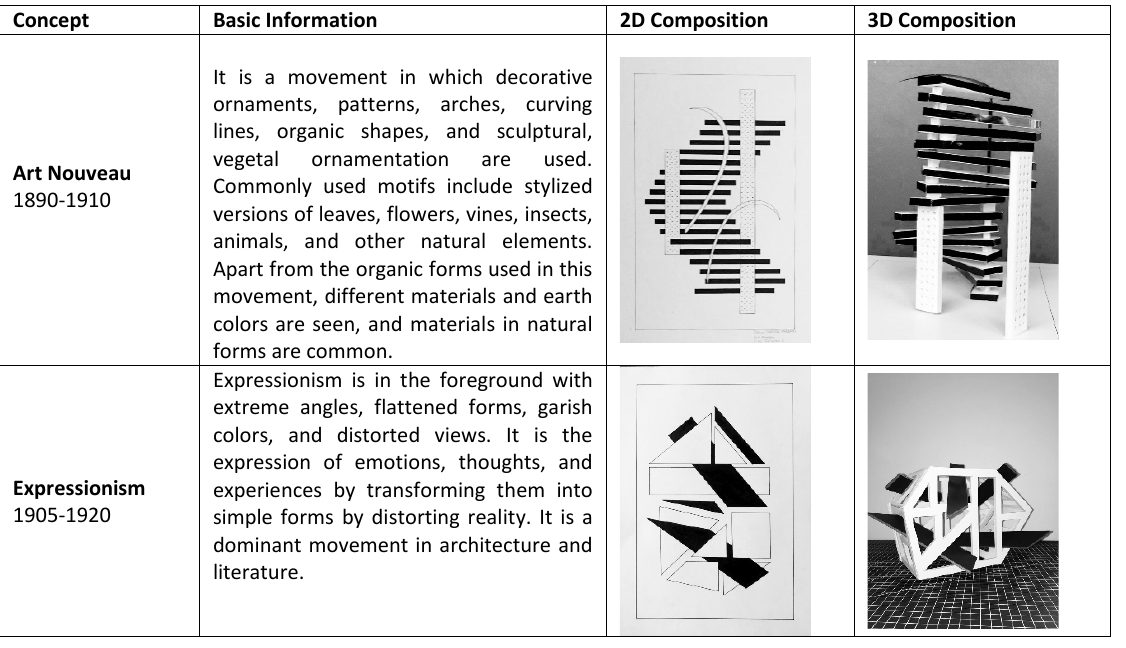
Table 2 Information about movement and 2d, 3d compositions prepared by